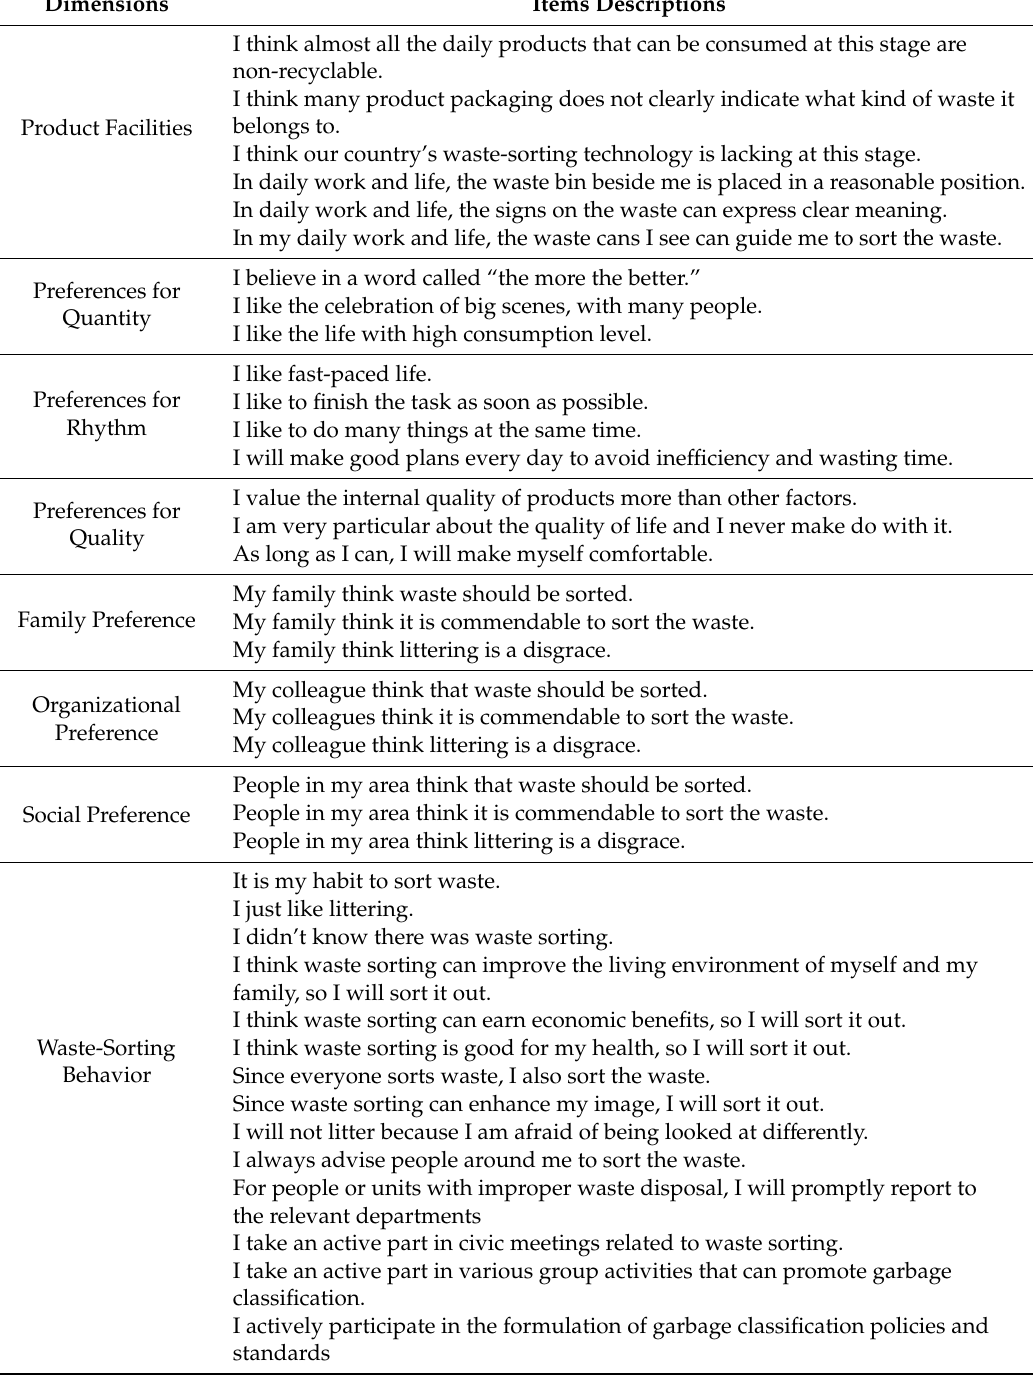
Table A1. The scale items for product facilities and preference framework and waste-sorting behavior.